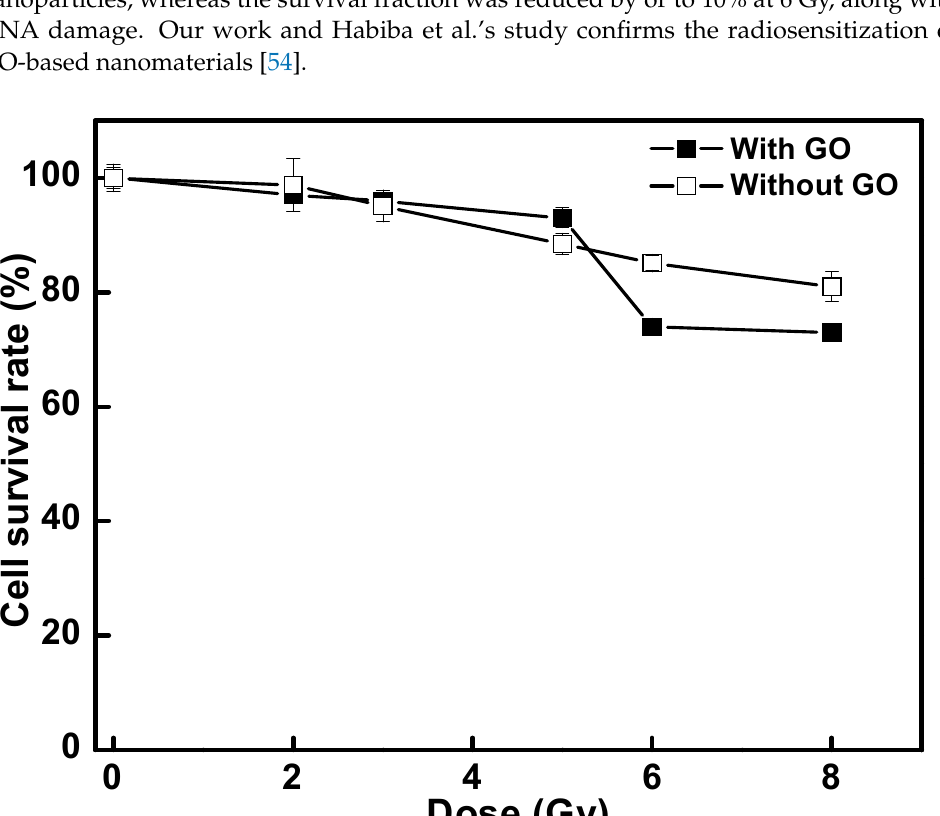
Figure 7. Radiation dose-response curve for NPC-BM1 cancer cells treated without and with a low-concentration of GO (at a concentration of 0.1 µ g · mL − 1 ). The values are expressed as the mean ± standard deviation of triplicate ( n = 3) measurements.